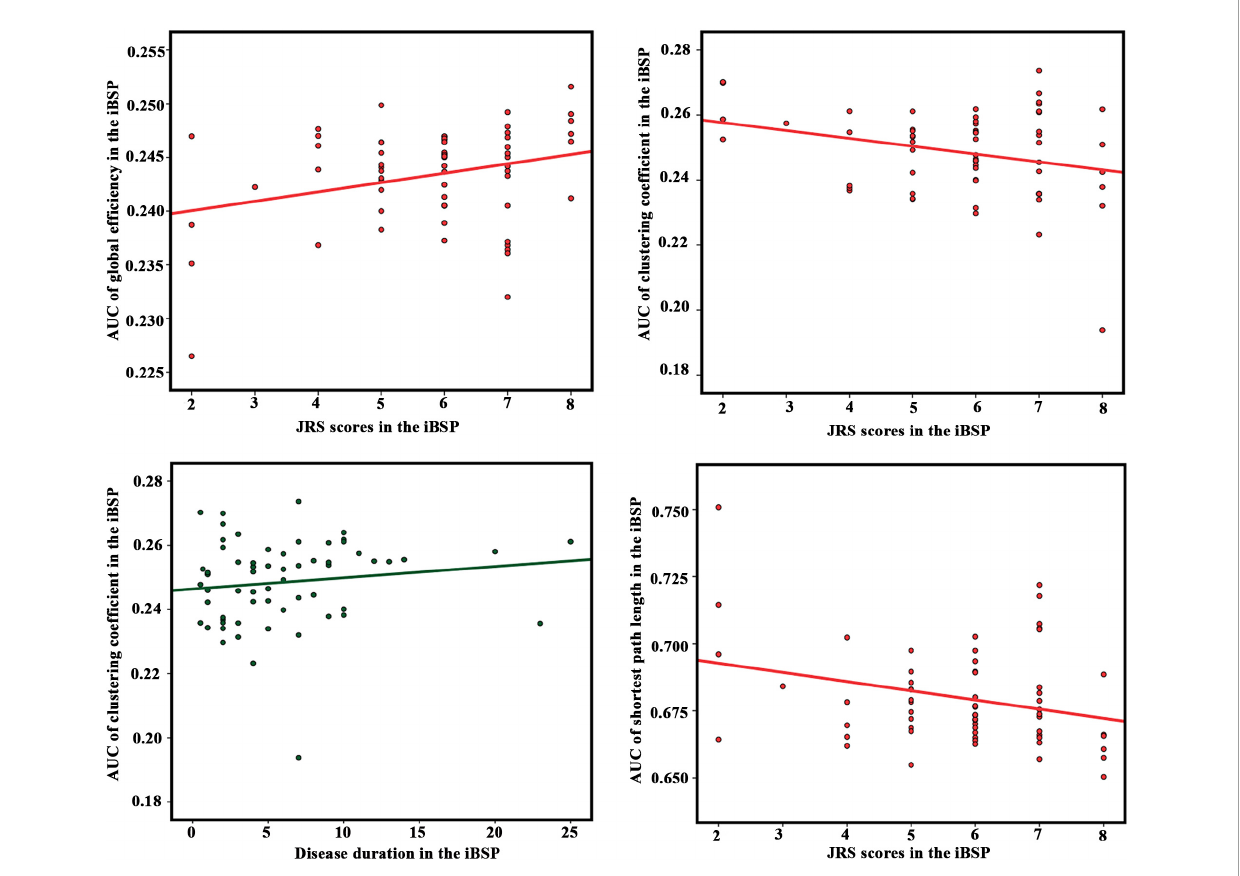
FIGURE4 Correlation results between network parameters and clinical measurements in the idiopathic blepharospasm group. Partial correlation analyses were performed with age and gender as covariates. The significance level was set as P < 0.05. AUC, area under the curve; idiopathic blepharospasm (iBSP), idiopathic blepharospasm; JRS, Jankovic Rating